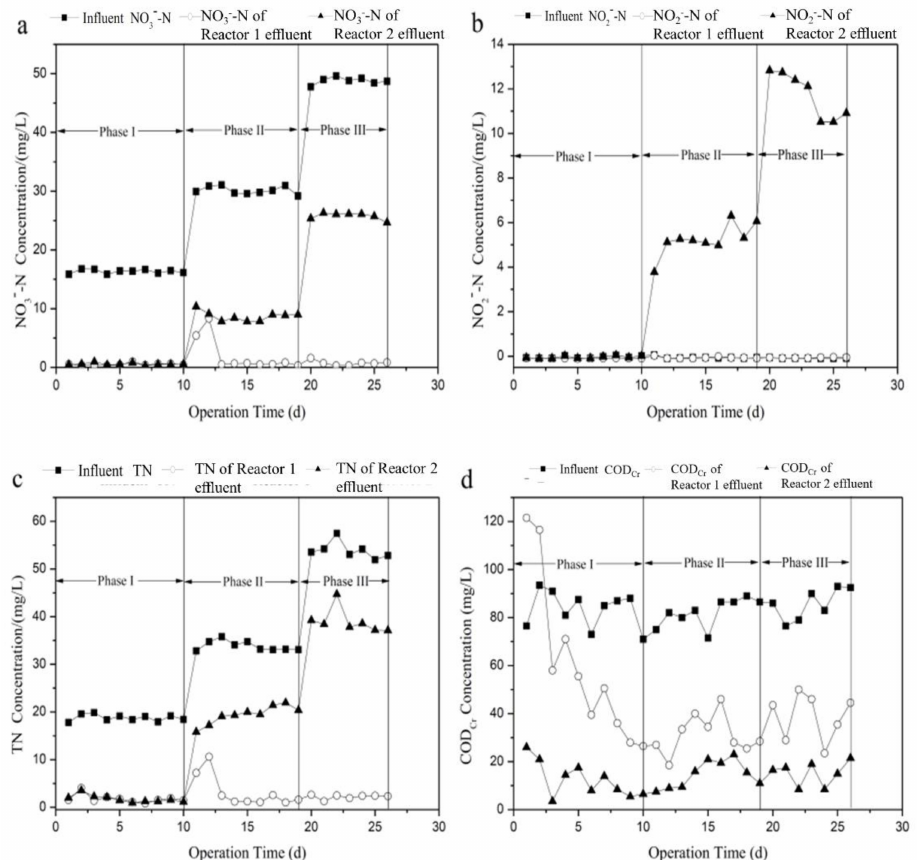
Figure 2. Variation of e ffl uent: ( a ) nitrate; ( b ) nitrite; ( c ) TN; and ( d ) COD Cr concentration of the two processes with time during start-up